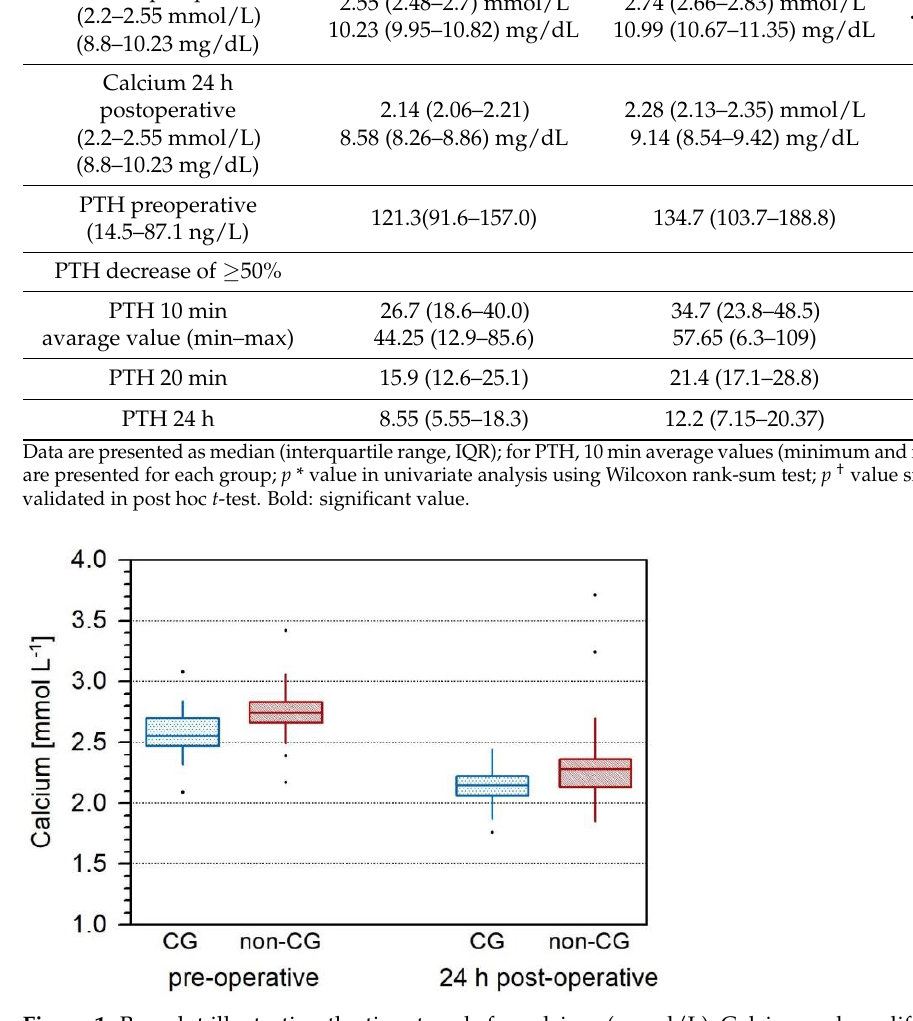
Figure 1. Box plot illustrating the time trends for calcium (mmol/L). Calcium values differ significantly in both groups, CG and non-CG ( p = 0.001), and calcium decrease is significant pre- and postoperatively ( p < 0.001) as well. However, calcium level change is similar and not significantly different between both groups. Table 1. Patients ’ baseline characteristics.